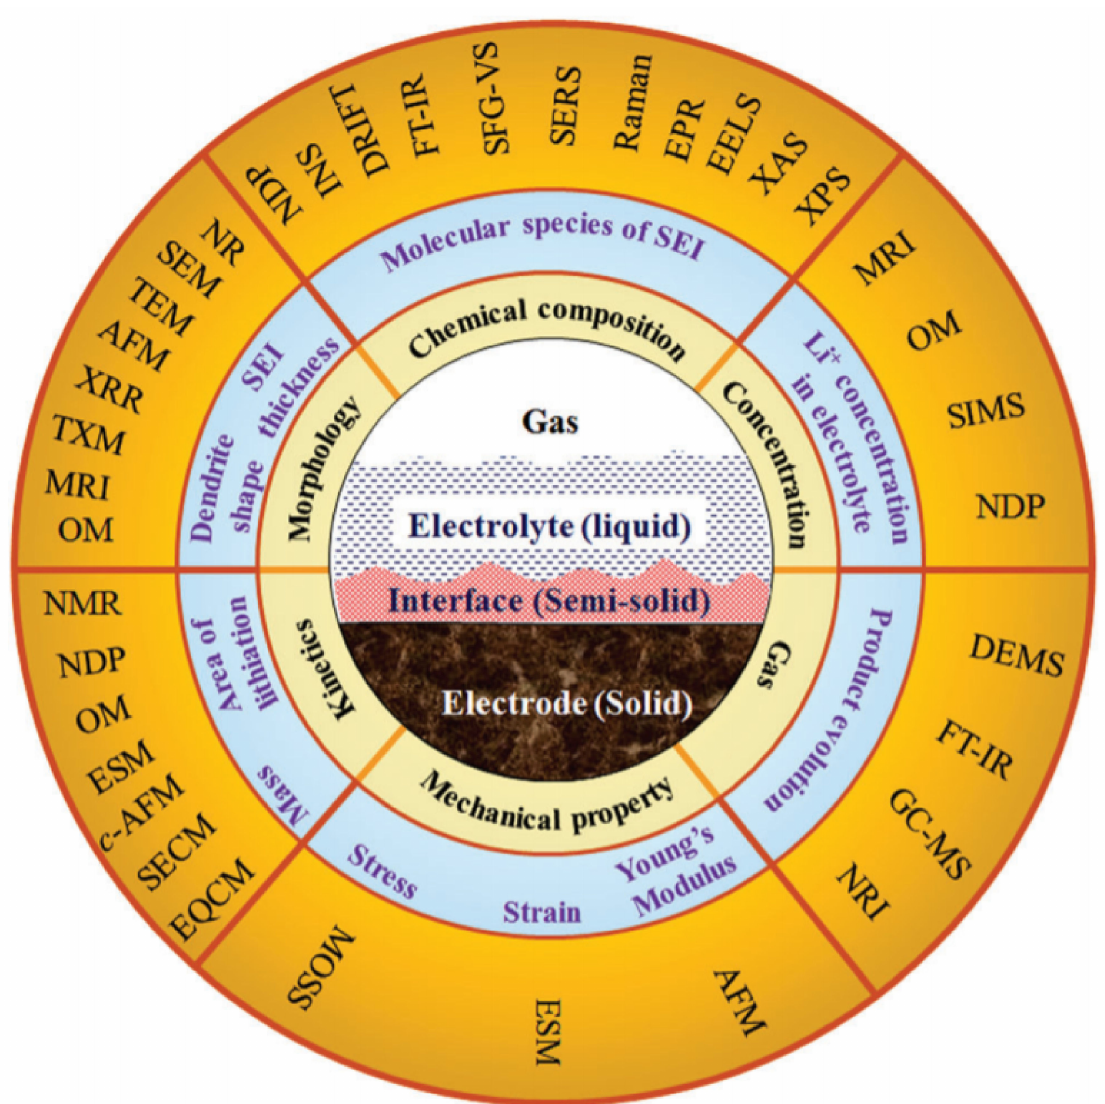
Figure 24. Analytical tools for analyzing electrode–electrolyte interface properties (adapted with permission from [219]. Chem Soc Rev, RSC,